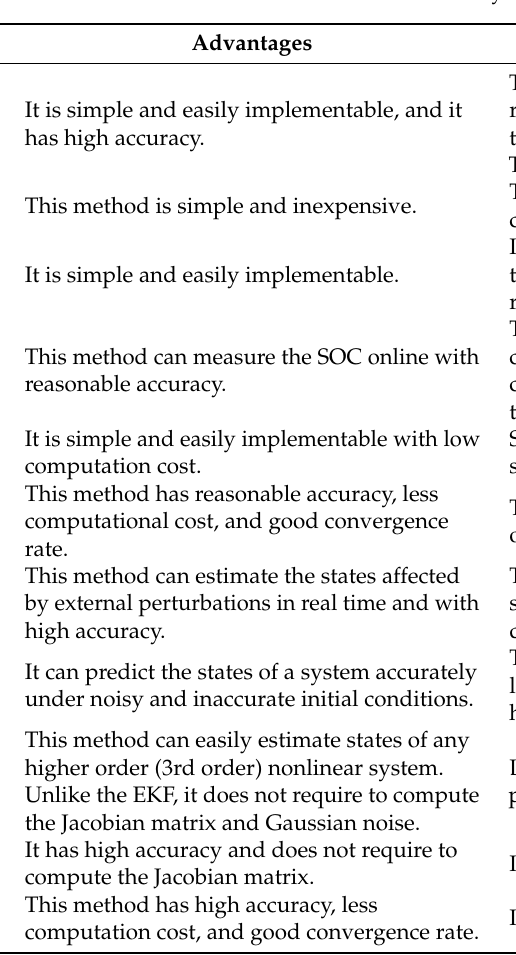
Table 22. Summary of the classified SOC estimation methods for Li-ion